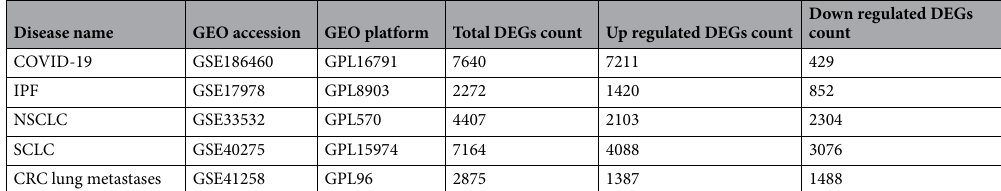
Table 1. A description of the datasets in this analysis together with their geo-features and quantitative